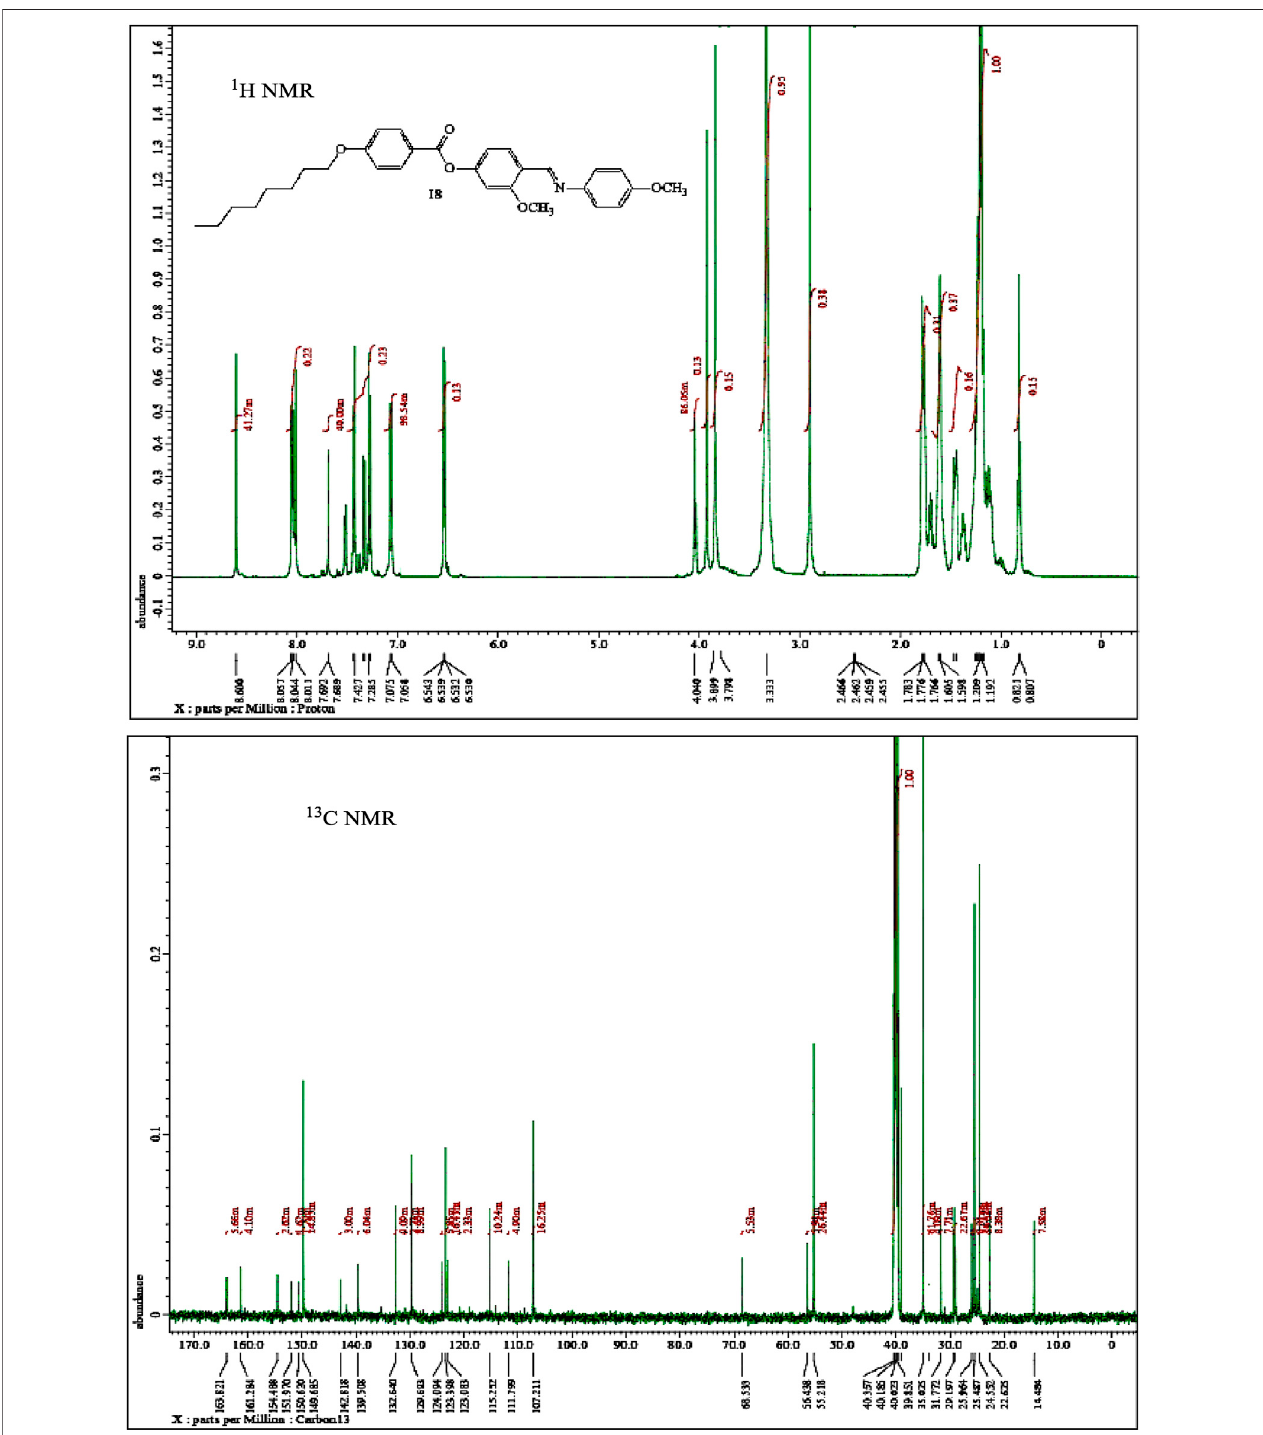
FIGURE 2 | NMR spectra of material A8